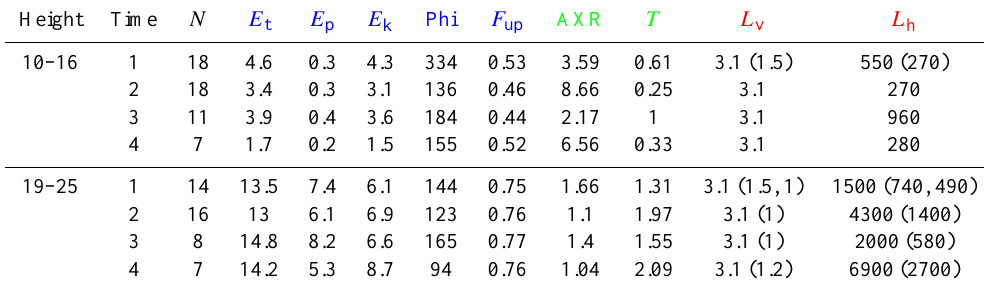
Table 4. Same as Table 1 but for TC Faxai at height ranges of 10–16km and 19–25km at several periods: 1 – before the birth of TC (1–10 December 2001), 2 – during the tropical storm (11–20 December 2001), 3 – during the tropical cyclone (21–25 December 2001) and 4 – at the death of the tropical cyclone (26–31 December